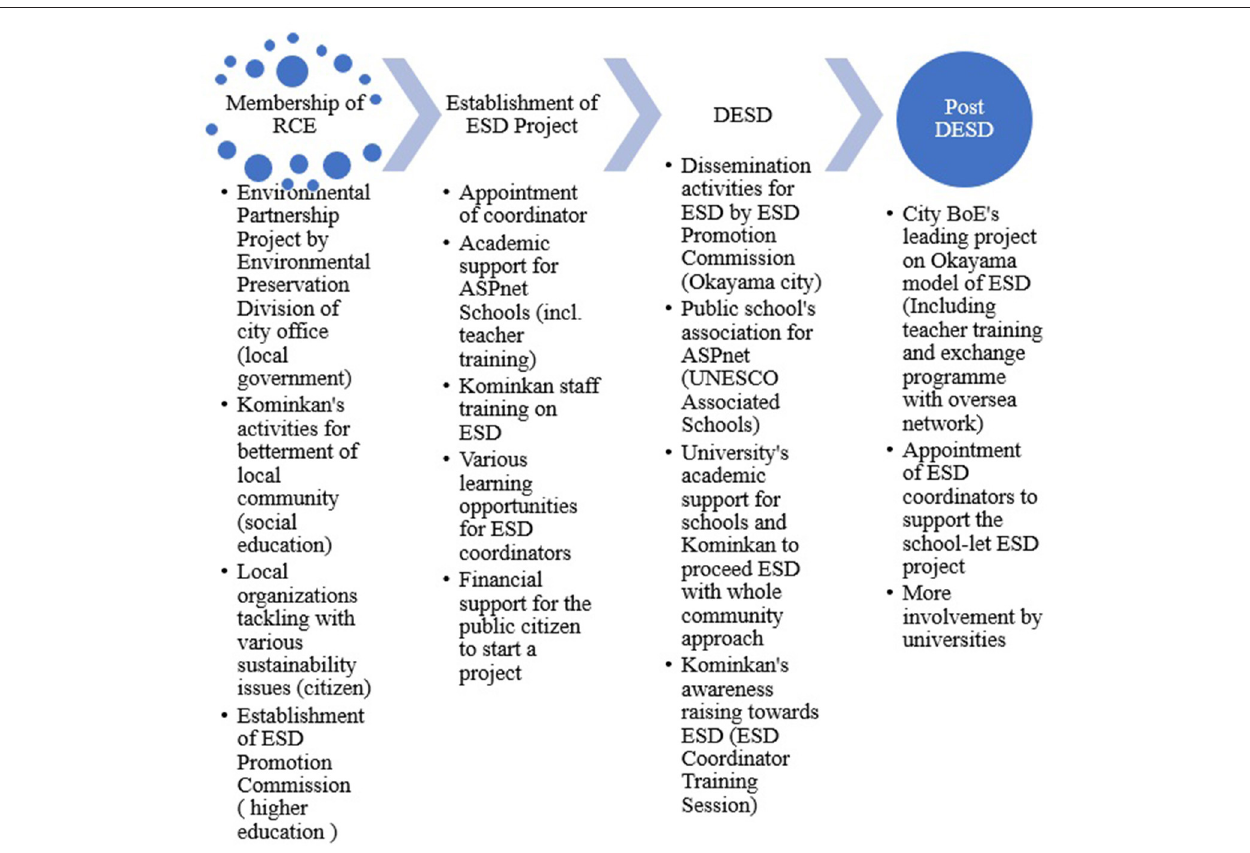
FIGURE 5 | The chronological sequence of Okayama